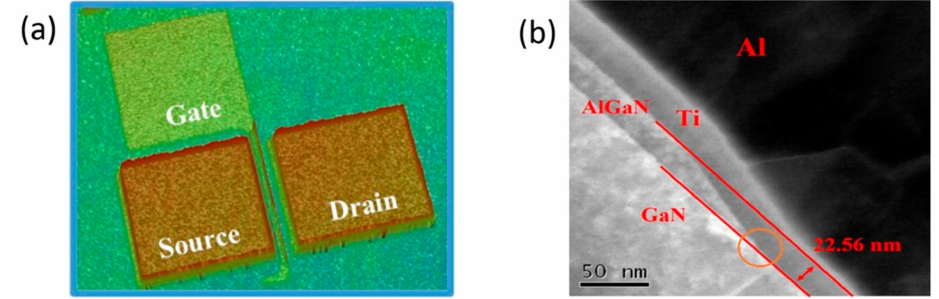
Figure 2. ( a ) Three-dimensional surface profiler. ( b ) TEM image of the fabricated